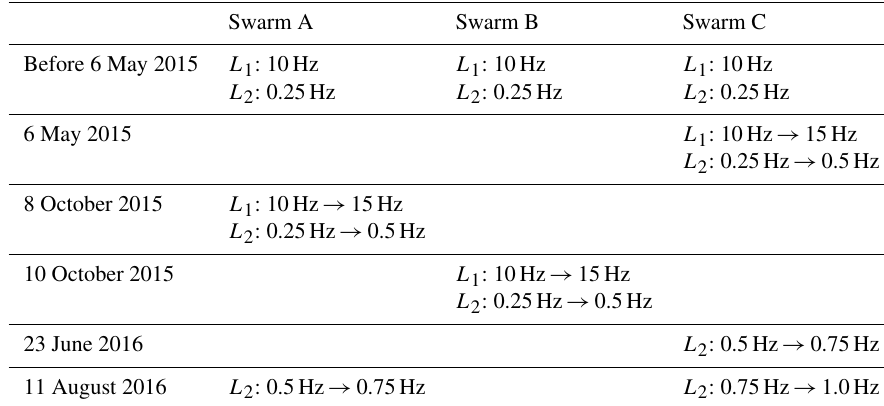
Table 1. Update of Swarm carrier loop bandwidth Swarm A Swarm B Swarm C